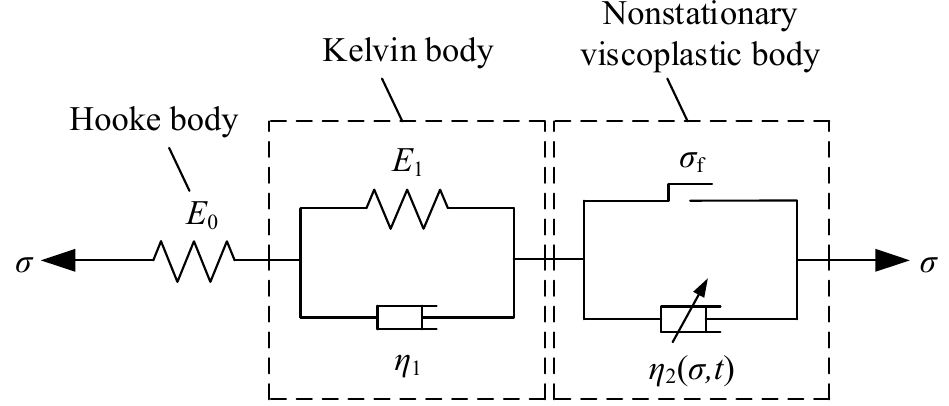
Figure 1. Rheological model with variable viscoplastic viscosity coefficient. In Figure 1, E 0 is the elastic modulus of a Hooke body; E 1 and η 1 are the elastic modulus of a Hooke body and the viscosity coefficient of a Newton body in a Kelvin body, respectively; σ f and η 2 are the yield stress of a St. Venant body and the viscosity coefficient of a dashpot in the non-stationary viscoplastic body, respectively, and η 2 is as a function of stress σ and time t . When σ ≥ σ f , for the nonlinear Bingham body, the expression of the viscosity coeffi- cient η 2 is denoted by Equation (1)